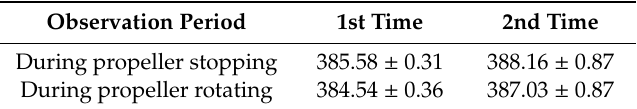
Table A6. CO 2 concentrations (mean ± standard deviation) in ppm measured by the UAV system during propeller stopping and rotation times on the surface of measuring